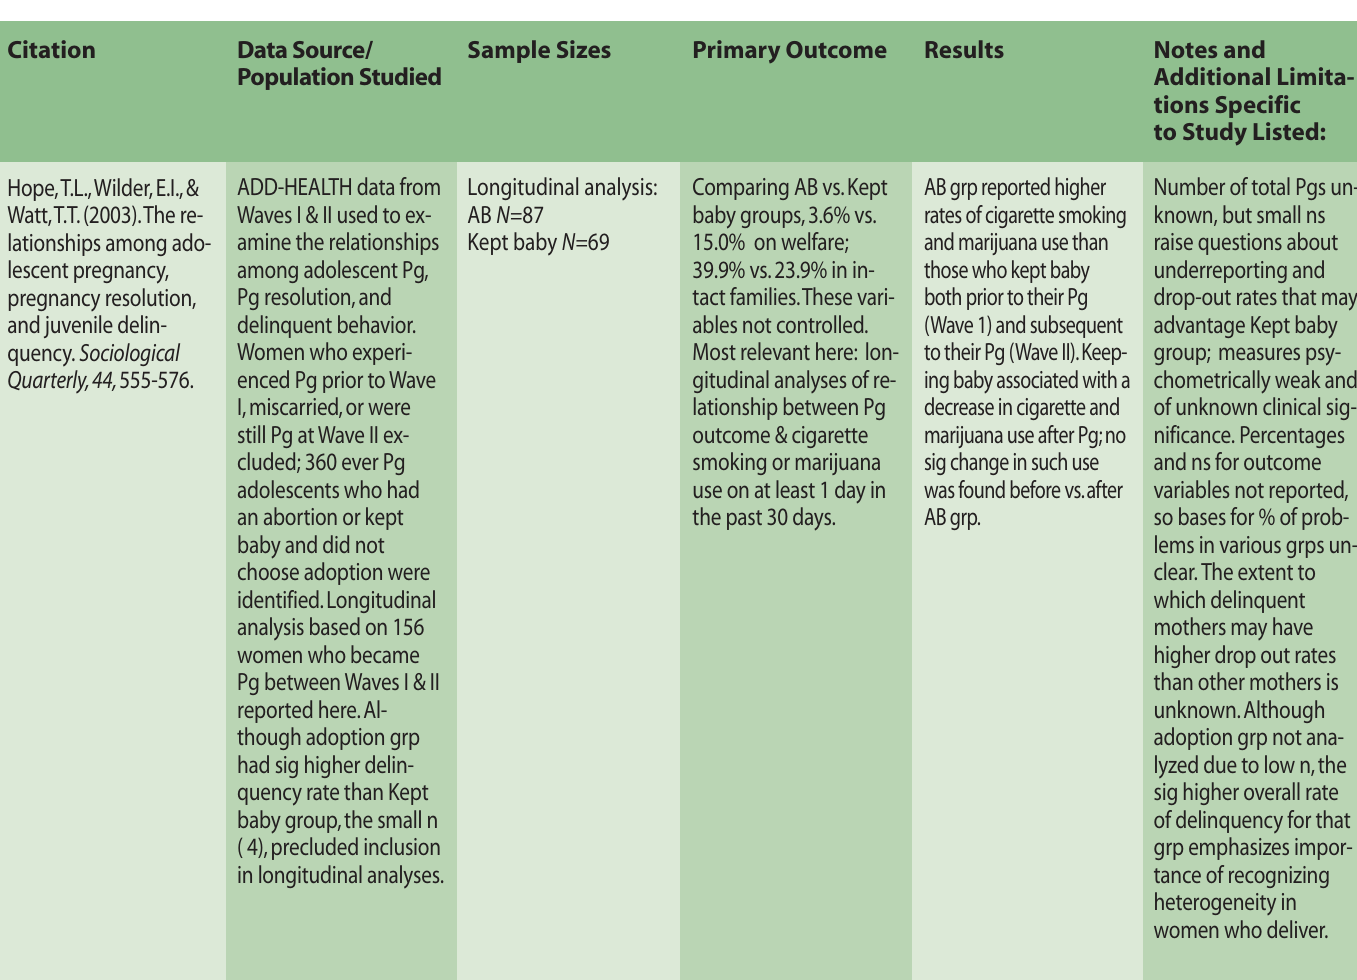
Table 2: Secondary Analyses of Survey Data–Abortion vs.Comparison